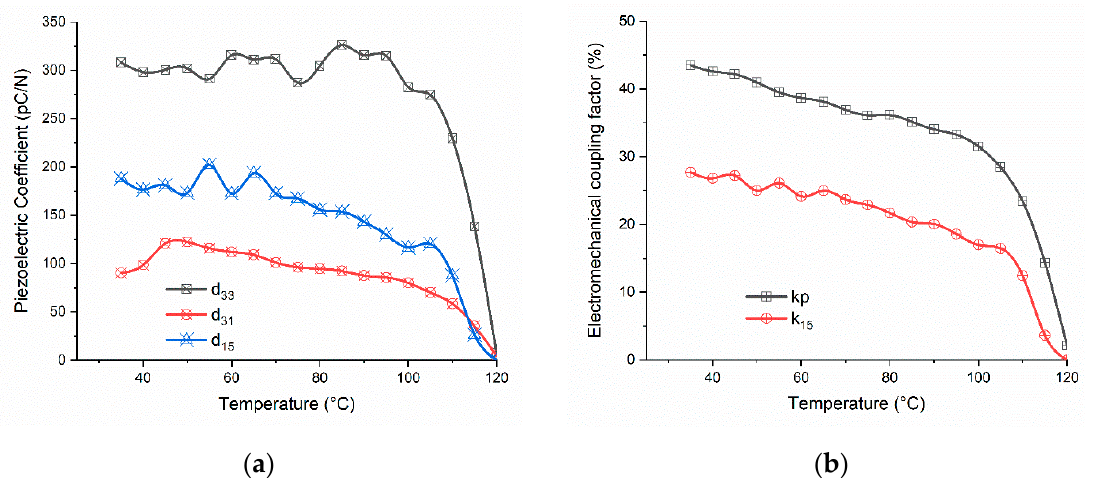
Figure 5. Thermal stability analysis of ( a ) piezoelectric coefficients and ( b ) the electromechanical coupling factors of BCTZ8-5 ceramics obtained from the radial and shear resonances of thickness- poled thin disks and plates of BCTZ8-5 ceramics.